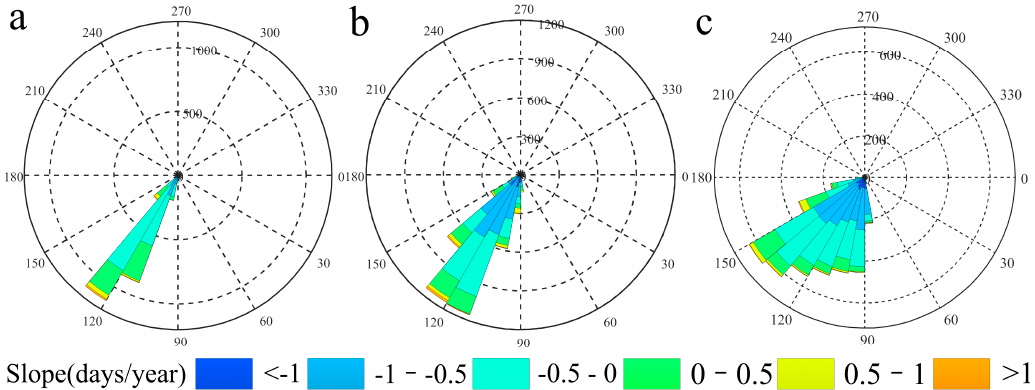
Figure 4. 34 year average of SOS and its change trends for different vegetation types: ( a ) meadow steppe, ( b ) typical steppe, and ( c ) desert steppe. Each bin represents a 10 day range of SOS. The height and color of each bin indicate the number and fitting slope (i.e., the change trend) of the pixels that fall within the bin, respectively, with the color bar of the slope on the bottom of the figure. Only statistically significant trends ( p < 0.05) are included.